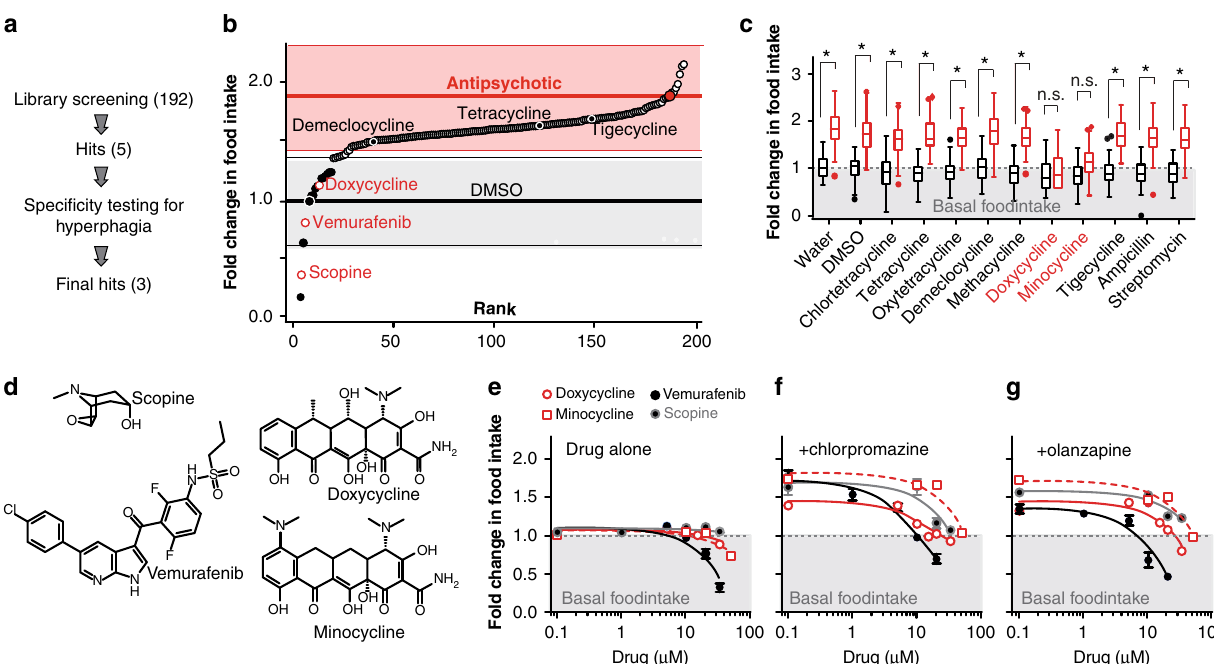
Fig. 2 C. elegans based screen of FDA-approved drugs for potential adjuvant to block AP-induced hyperphagia. a Diagram of screening process. b Food intake based screen of 192 compounds in C. elegans in the presence of 50 µ M of the AP loxapine (See Supplementary Data 1 and 2 for details). c Tukey style plot representing effects on food intake of various antibiotics alone (33 µ M, black) or in combination with the AP loxapine (50 µ M, red). d Structural comparison of primary hits identi fi ed from C. elegans based food intake screen. e Effect of primary hits on basal food intake in the absence of AP. f Effect of primary hits on chlorpromazine-induced hyperphagia. g Effect of primary hits on olanzapine-induced hyperphagia. Error bars in e – g represent + / − S.E.M. Food intake was measured using the bacterial clearance assay, 23 feeding dead, γ -irradiated bacteria. Data expressed as mean fold change in food intake relative to untreated N2 (wild-type) after 72 h. Asterisks (*) represent p < 0.05 (ANOVA, Bonferroni corrected), n.s. not signi fi cant. Source data